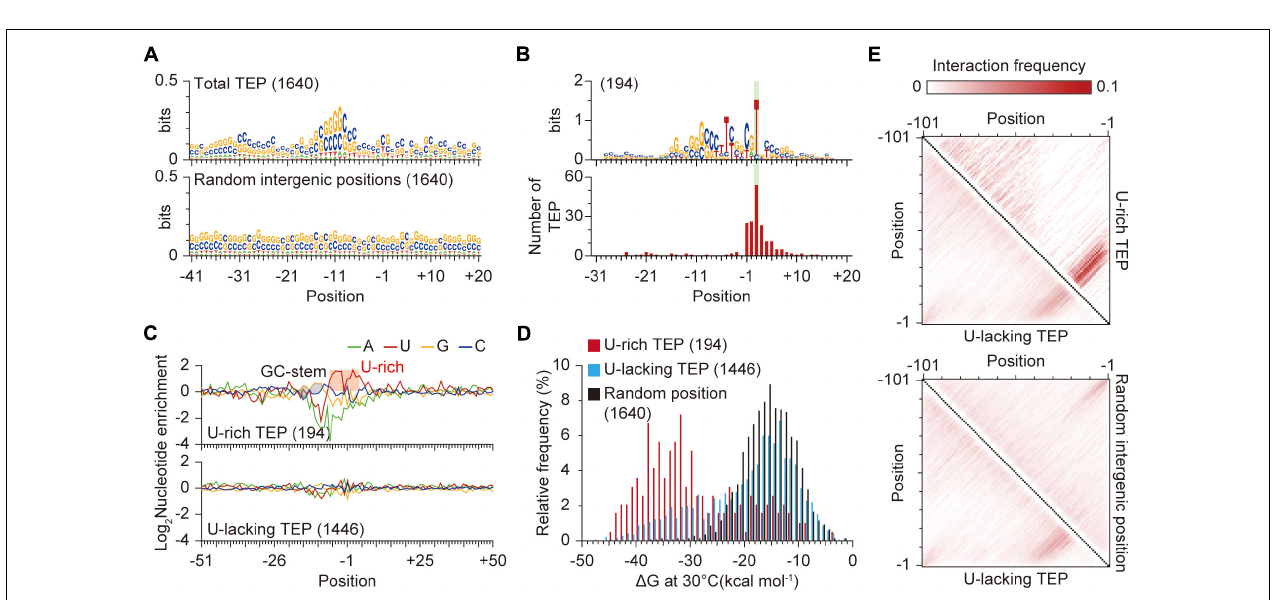
FIGURE 5 | Identification of a U-rich motif near transcript 3 (cid:48) -end positions (TEPs). (A) Sequence alignment near TEPs or randomly selected intergenic positions. The 41 nt upstream to 20nt downstream sequences of TEPs were used for sequence logo generation using Weblogo. (B) The conserved U-rich motif. (C) Nucleotide enrichment analysis of the two types of TEPs. Nucleotide enrichment was calculated by dividing the frequency of each nucleotide for the TEP sets with the frequency of the same nucleotide of randomly selected intergenic positions. (D) (cid:49) G distribution of TEPs. The (cid:49) G was calculated from upstream 41 nt sequences, including TEPs or randomly selected intergenic positions using RNA fold with the temperature parameter of 30 ◦ C. (E) Structure comparison between U-lacking TEPs, U-rich TEPs and randomly selected intergenic positions.